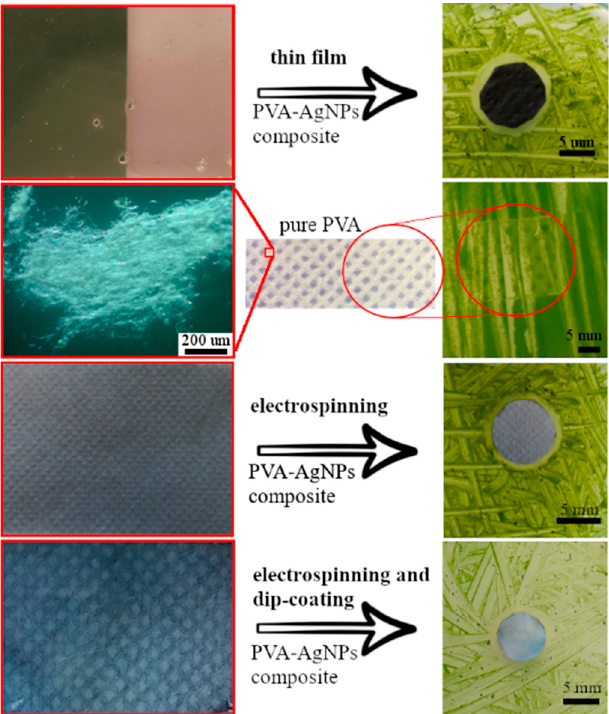
Figure 10. The anti-biofilm effect of the PVA–AgNPs composites’ thin layer (sample I); of pure PVA fibers and PVA–AgNPs composite fibers (sample B) prepared by electrospinning and dip-coating (shown from top to bottom).